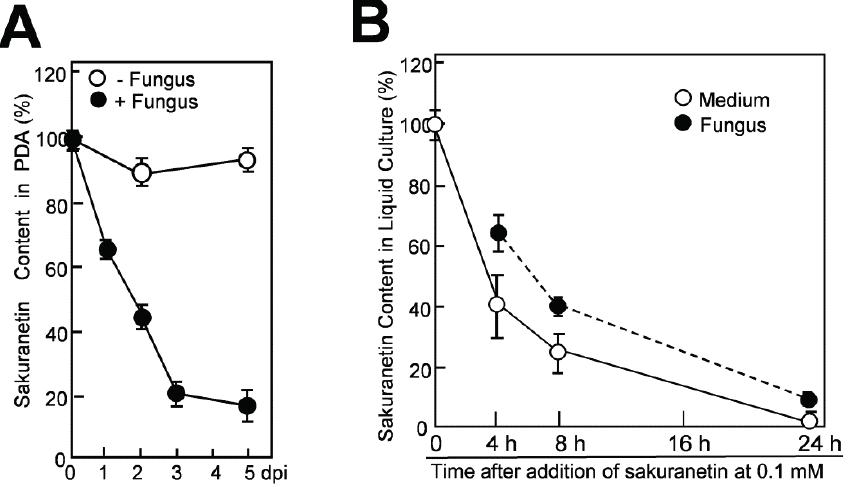
Figure 4. Decrease of sakuranetin in the blast mycelium culture. ( A ) Decrease of sakuranetin content in solid medium PDA after being overlaid by blast mycelium layer (+Fungus) or mock-layer ( − Fungus). At time 0, 0.3 mM sakuranetin was present in the agar medium (100%), and sakuranetin in PDA was quantified thereafter; ( B ) Decrease in sakuranetin in liquid mycelium culture. At time 0, 0.1 mM sakuranetin was present in the PD liquid mycelium culture medium (100%). After incubation for the indicated time period, sakuranetin in the medium fraction and fungus mass fraction was quantified separately. Data are means ± SD from three independent